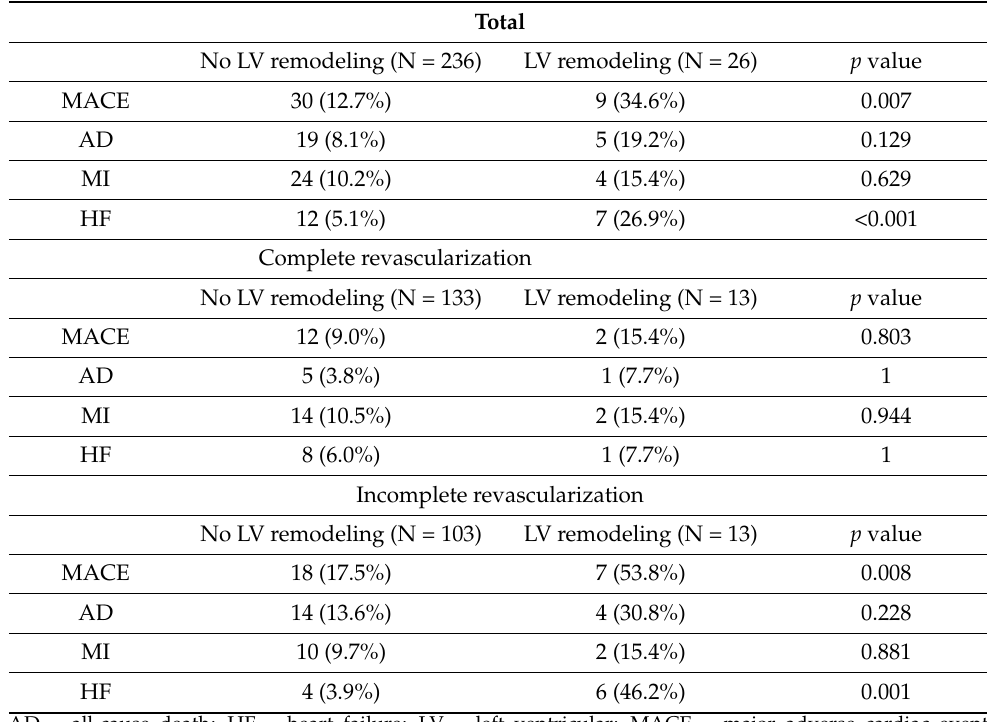
Table 4. Outcomes according to LV remodeling and PCI